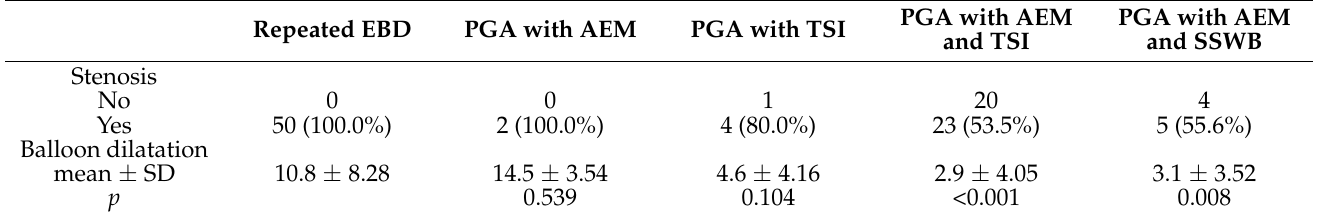
PGA with AEM PGA with AEM and TSI and SSWB